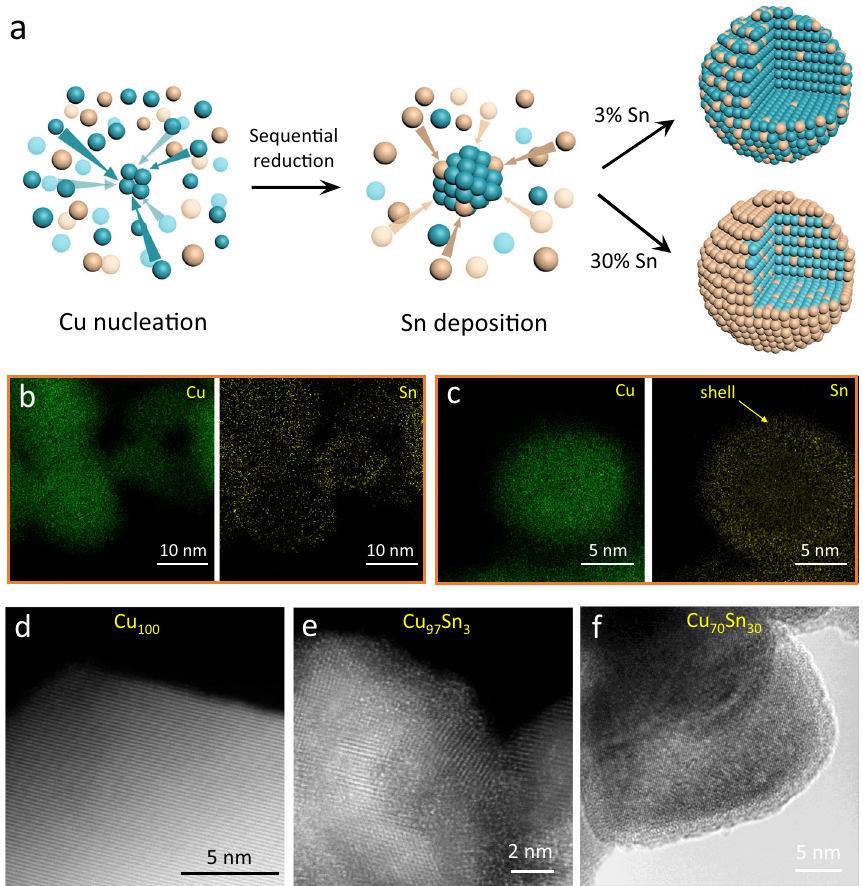
Fig. 1 Synthesis and structural characterization. a Schematic illustration of the Cu – Sn nanoparticle formation via the sequential reduction. STEM/EDX mapping images of Cu 97 Sn 3 ( b ) and Cu 70 Sn 30 ( c ). HAADF-STEM image of Cu 100 ( d ), Cu 97 Sn 3 ( e ), and Cu 70 Sn 30 ( f